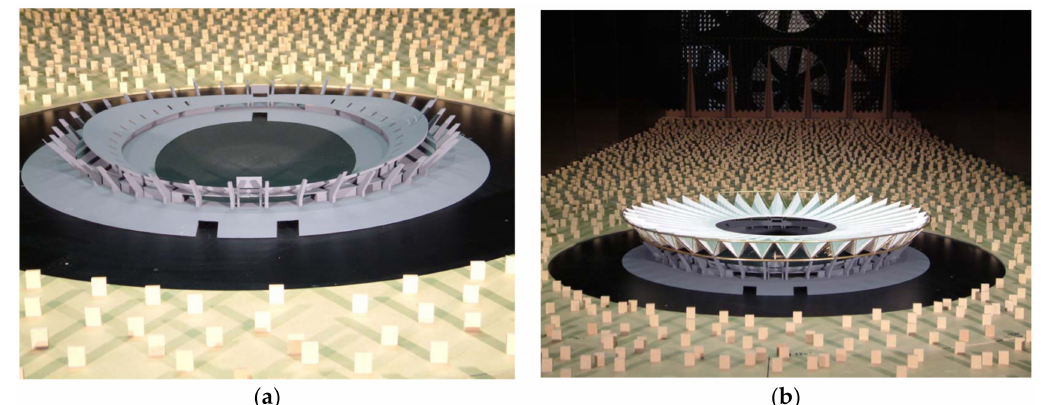
Figure 2. Model in the wind tunnel. ( a ) Bottom substructure model of FCLSC; ( b ) Integral structure model of